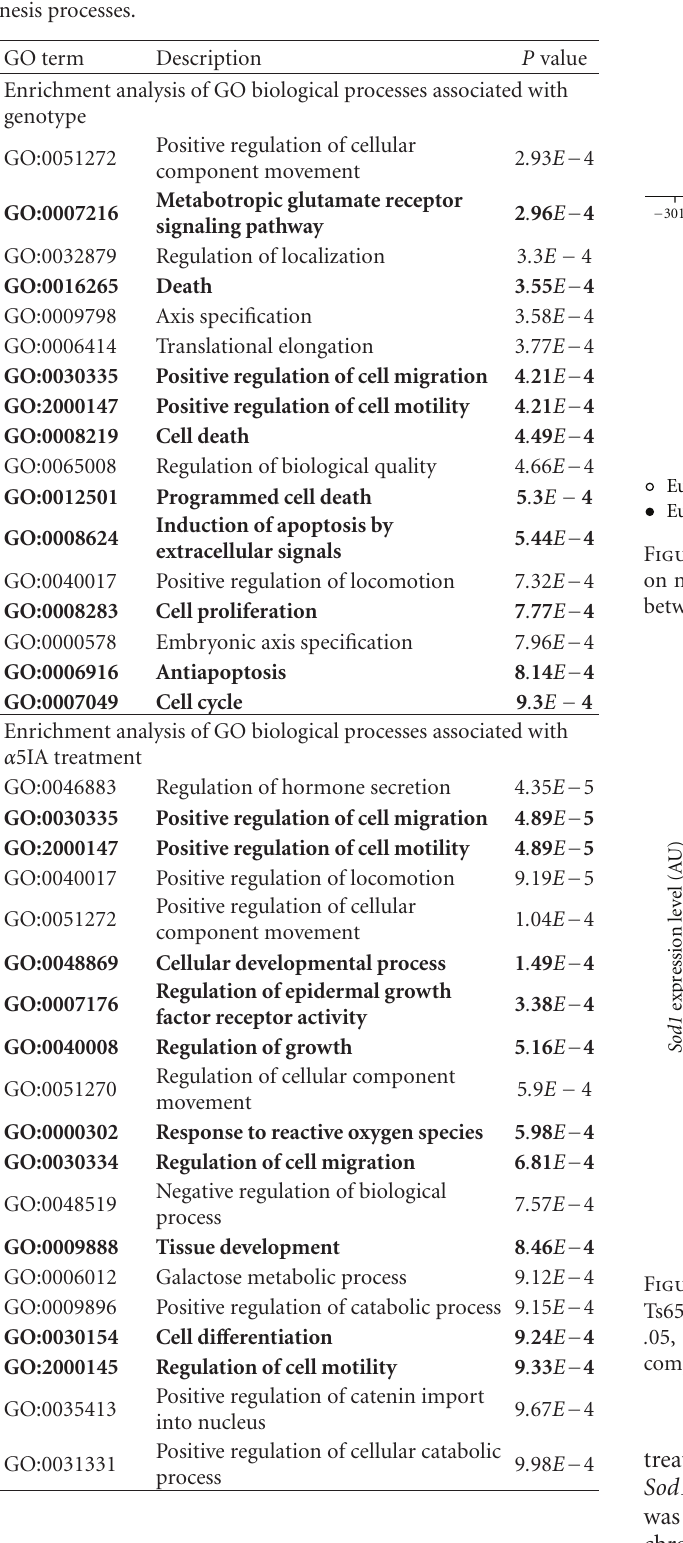
Table 2: Analysis of GO categories among the genes di ff erentially expressed in the hippocampus of Ts65Dn mice after α 5IA and behavioral stimulation. In bold GO categories related to neuroge- nesis processes.